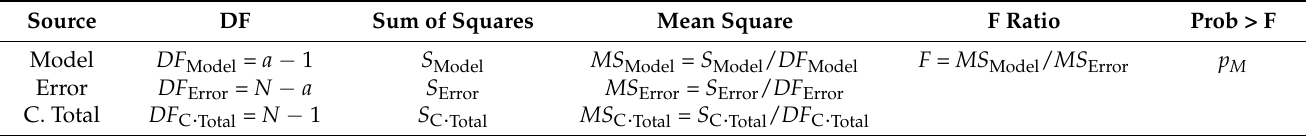
Table 6. General table of ANOVA